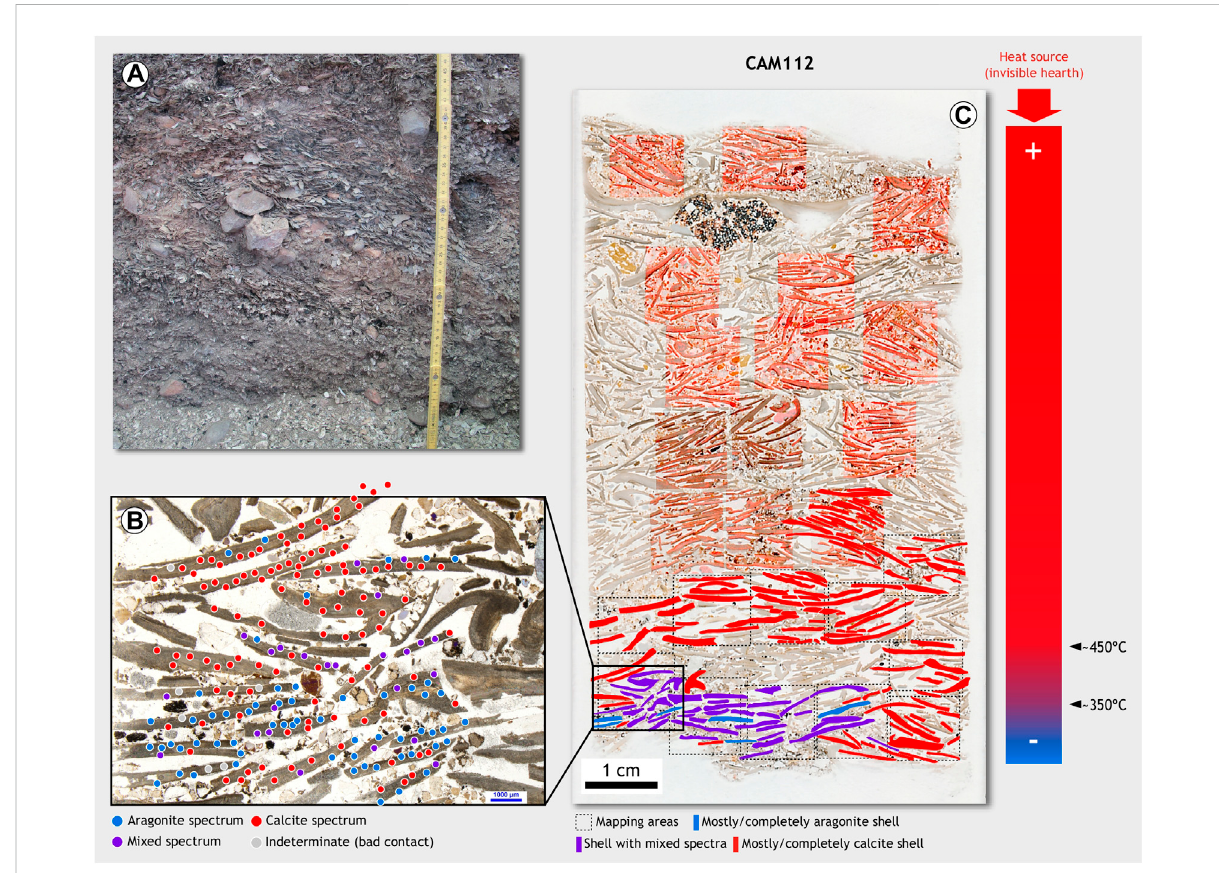
FIGURE 5 Sample CAM112. (A) Close-up of the fi eld pro fi le of the direct tossing deposits; note the absence of any evidence of structured combustion feature (B) Petrographic microphotograph showing an example of how the points to obtain FTIR measurements were distributed through the archaeological shells in the mapping areas; note the distribution of heated (calcitic) shells in the top of the image, while the shells in the bottom are not completely thermo-altered, with mainly aragonitic mineralogy, and the measurements of mixed mineralogy concentrate in the transitional area. (C) Thin section scan showing the mapping areas of ~1 cm 2 (dashed rectangles) and individual shells ’ mineralogy obtained; the not-dashed rectangle indicates the location of the microphotograph A, and the rectangles with reddish fi lter indicate mappings where all shells are calcitic; the verticalbartotherightshowstheapproximatepaleotemperaturegradientexperiencedbytheshellswhensubjectedtopost-depositional fi replaced on top of the deposit, and invisible at the macroscopic